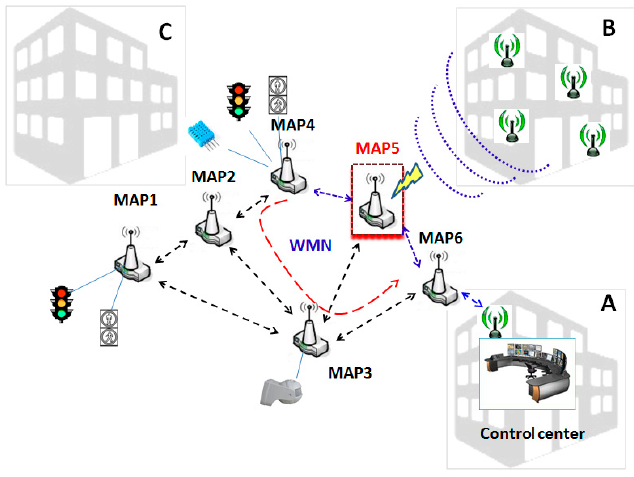
Figure 2. MAP5 is being interfered generating service disruptions due to traffic from building B.